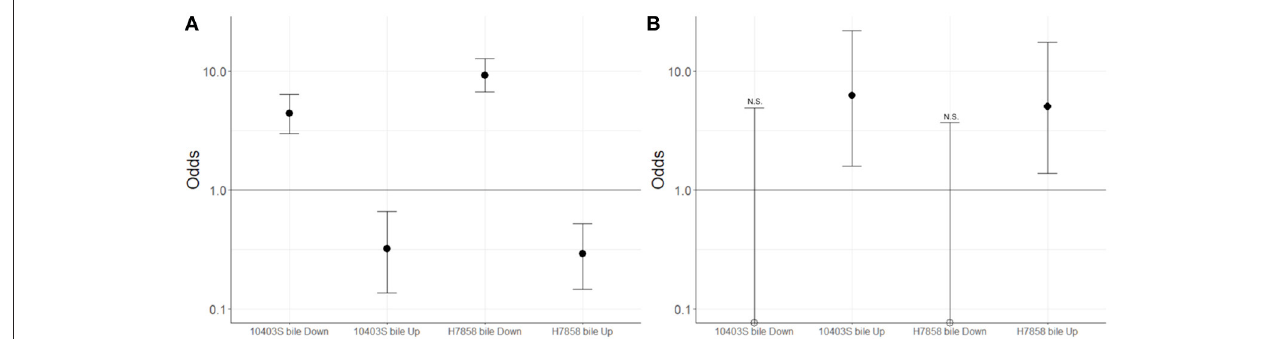
FIGURE 3 | Association between genes classified here into the bile stimulon and SigB or PrfA dependent genes. For strains 10403S and H7858, two-sided Fisher’s exact test was used to assess whether genes up- or down-regulated in bile were associated with (A) the SigB regulon or (B) the PrfA regulon. Odds ratio values are plotted with error bars representing the 95% confidence intervals. The y-axis is shown in log scale. FDR correction for multiple testing was applied and adjusted p < 0.05 were considered significant. Empty circles represent odds ratio values that were exactly zero and were therefore plotted on the x-axis. N.S. indicates odds ratio values that are not significantly different from 1; all odds ratio values that are not marked with NS were found to be significantly different from 1.